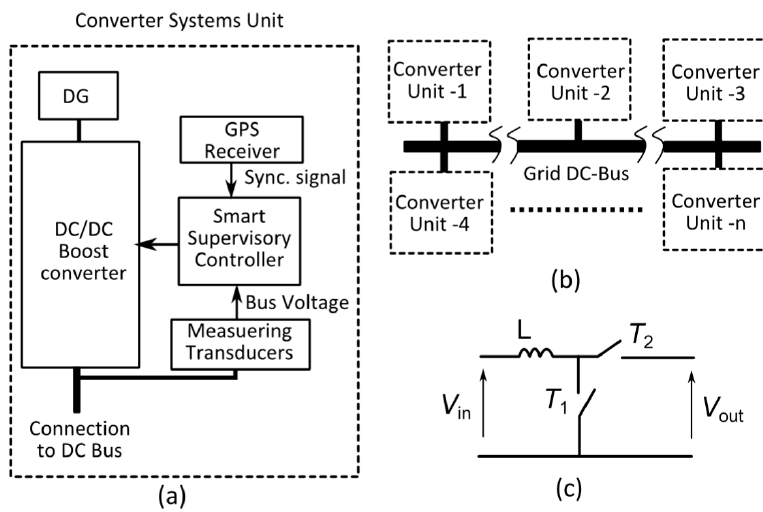
Figure 1. Proposed system block diagram ( a ) one unit of the converter system including controller; ( b ) DC Bus connected to n-unit converter system; ( c ) conventional boost converter.